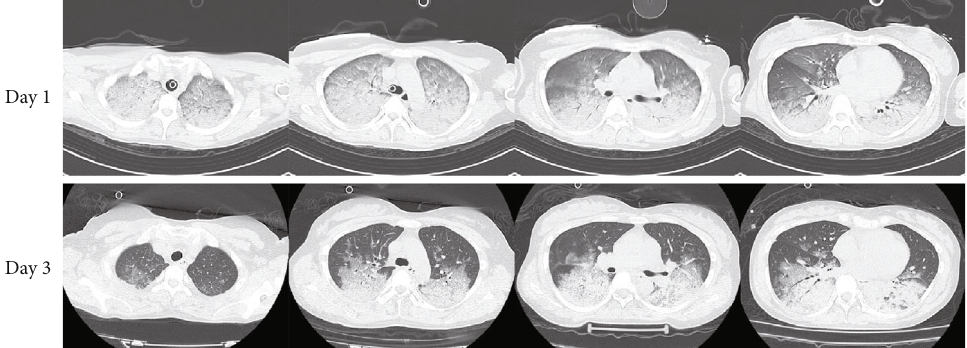
Figure 2: Chest computed tomography images on days 1 and 3 of admission. The scan on admission (day 1) showed bilateral pulmonary consolidations accompanied by air bronchogram and the ground-glass opacities. After extubation (day 3), the consolidations and opacities tended to improve but still